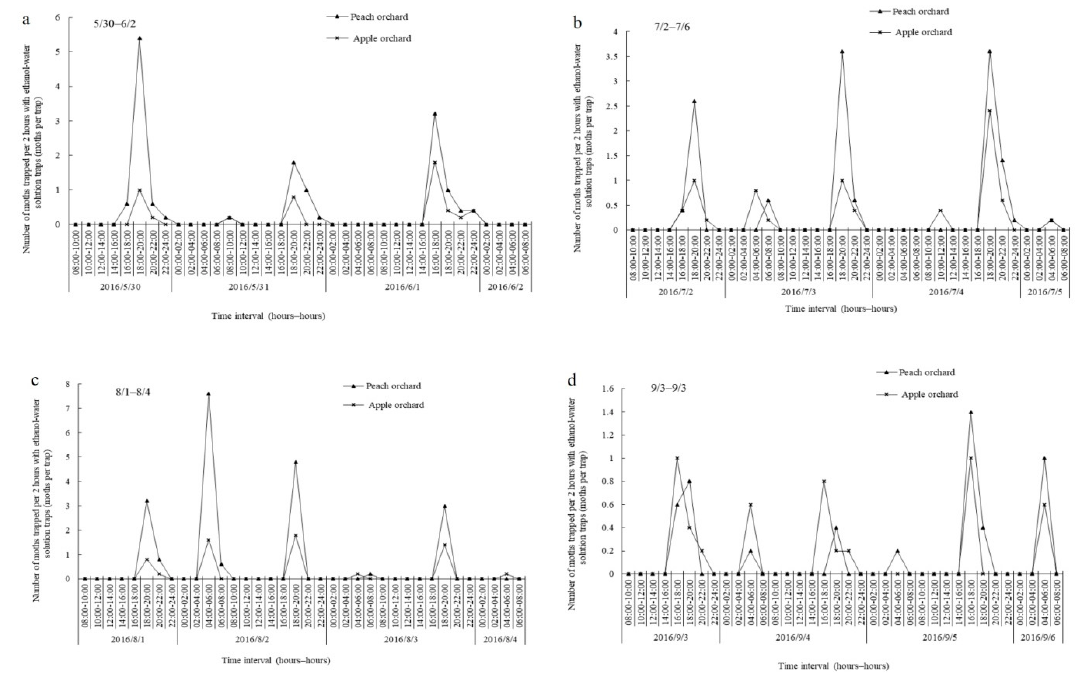
Figure 2. Diurnal flight activity of Grapholita molesta (Busck) adults in apple and peach orchards